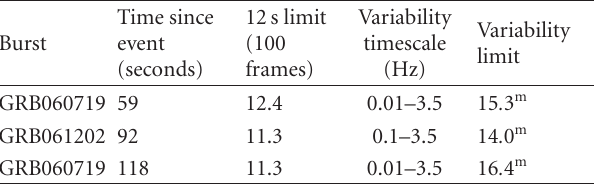
Table 3: Upper limits on the constant flux and sinusoidal variability of gamma-ray bursts, observed by TORTORA wide-field camera in follow-up